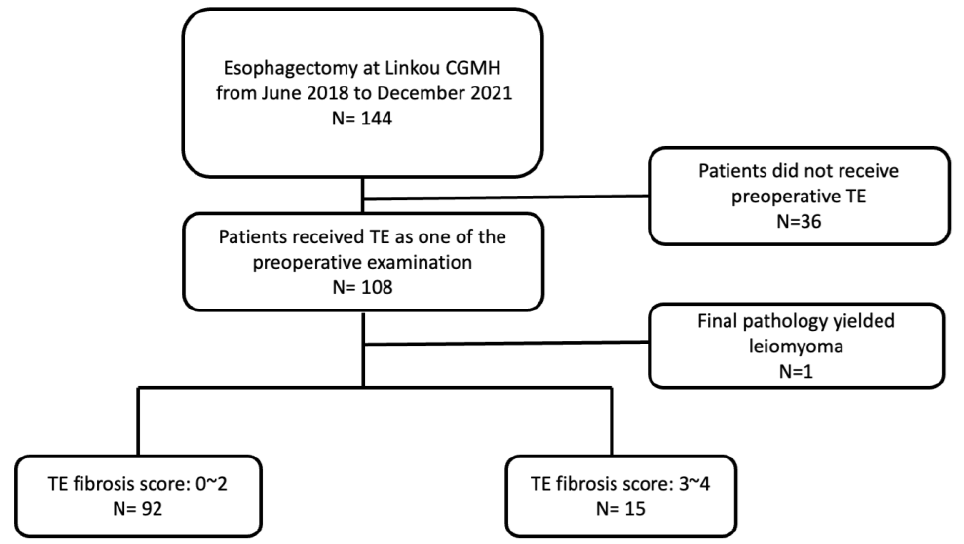
Figure 1. Algorithm of patient inclusion for the current